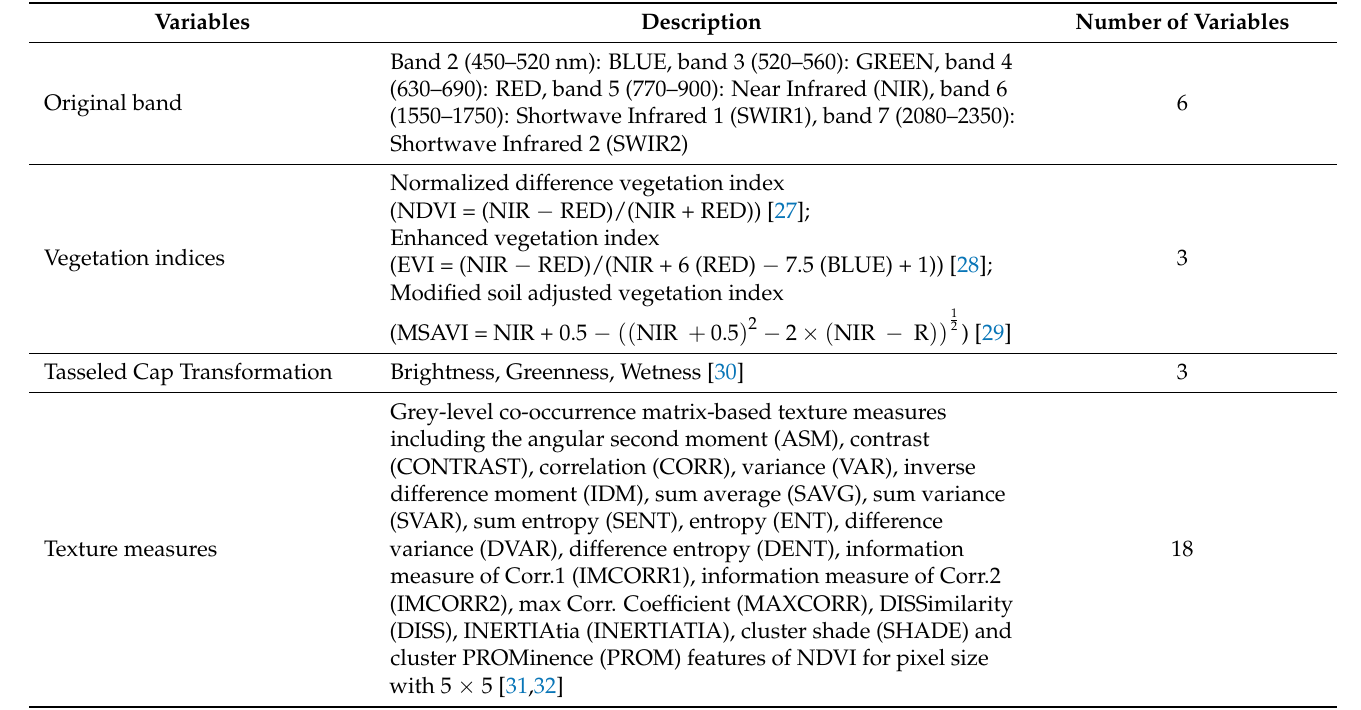
Table 3. The variables derived from the Landsat series